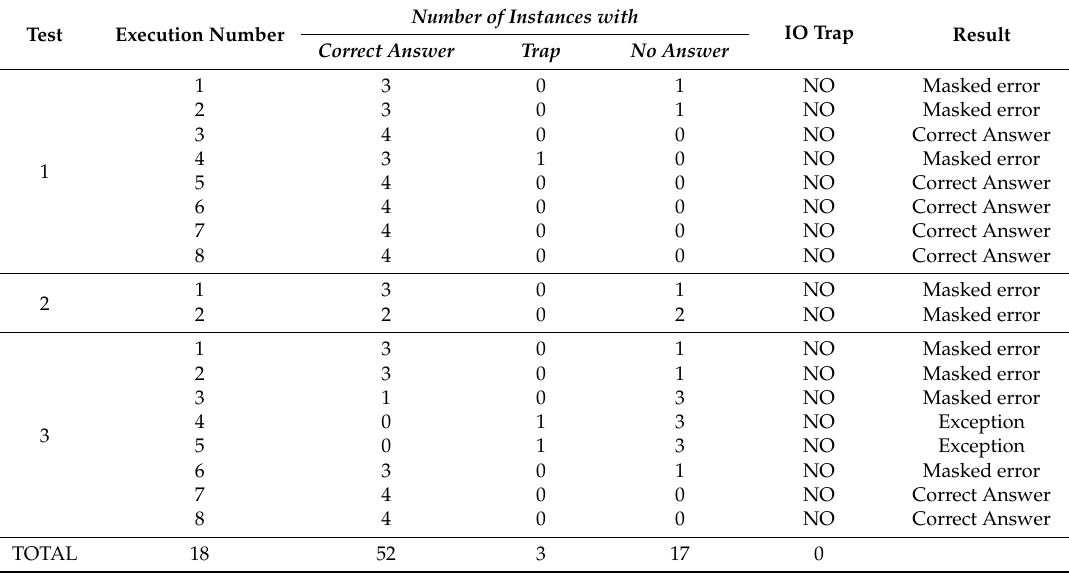
Table 4. Evaluation details of TSP NMR-MPar for 16